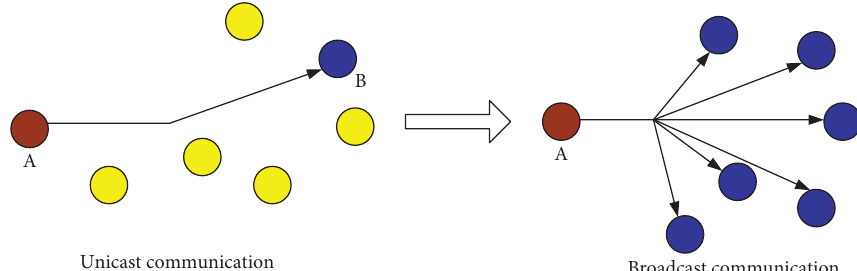
Figure 4: Robot controller communication